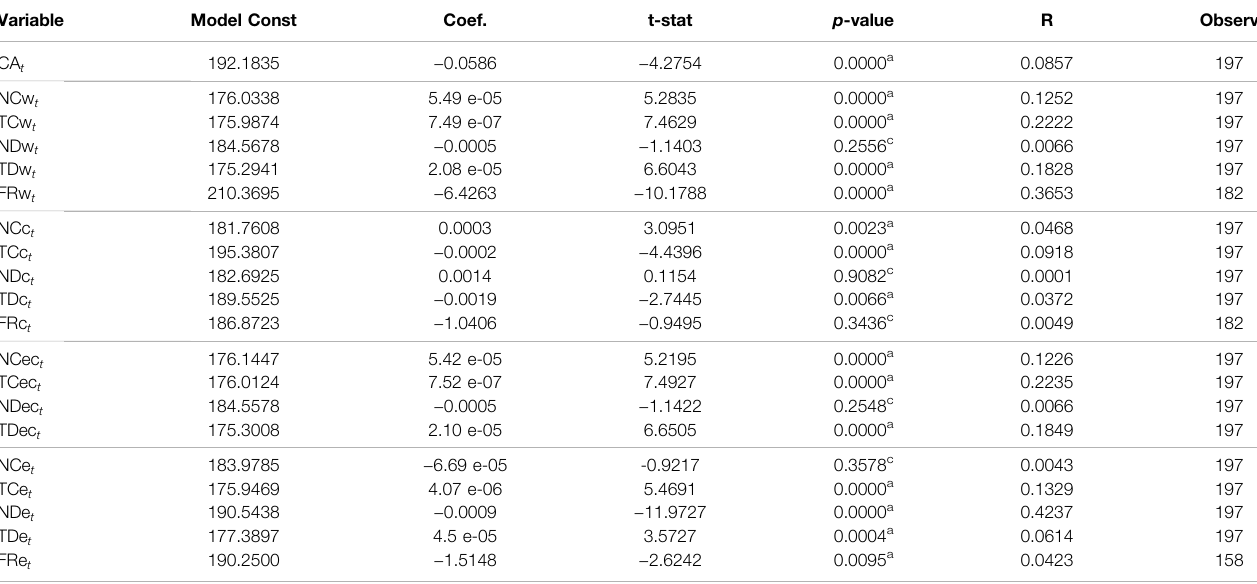
TABLE 8 | Bivariate regression models for COVID-19 effect on S&P Global 1200 ESG